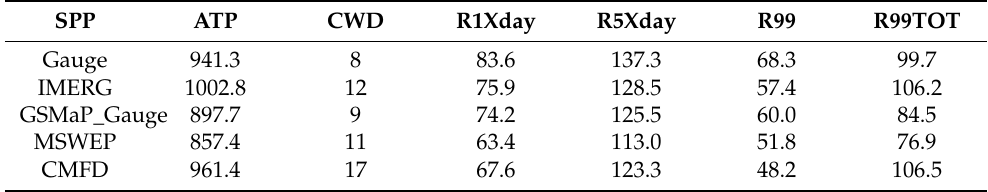
Table 3. The extreme precipitation indices of the SPPs data in urban area of